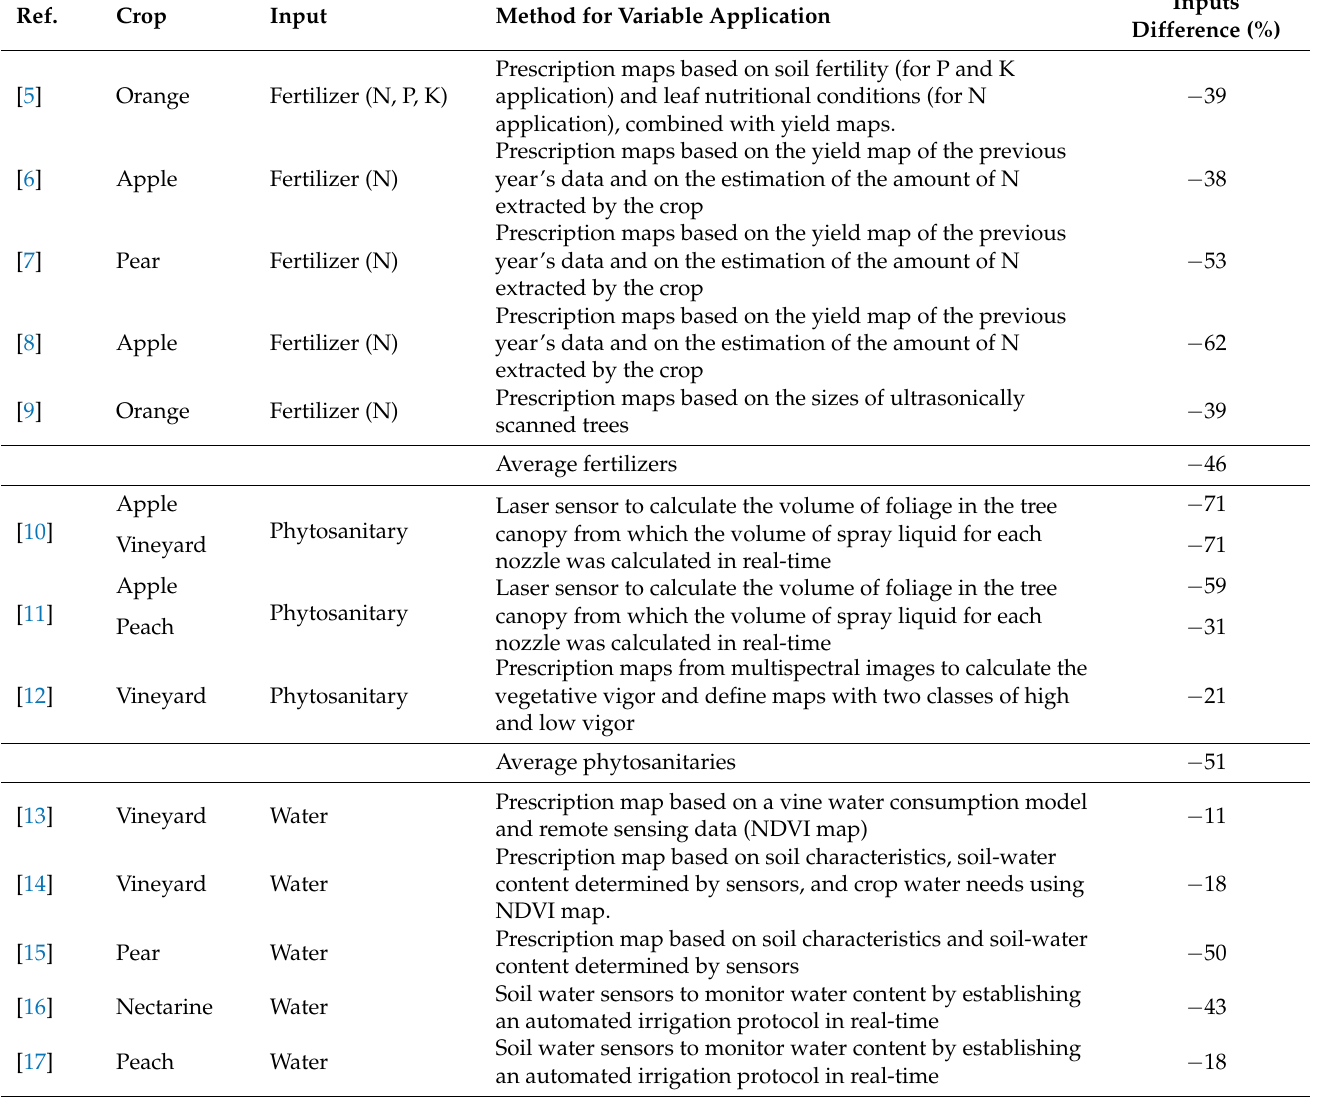
Table 1. Literature review on the percentage of difference in the use of inputs per ha − 1 year − 1 between uniform and variable